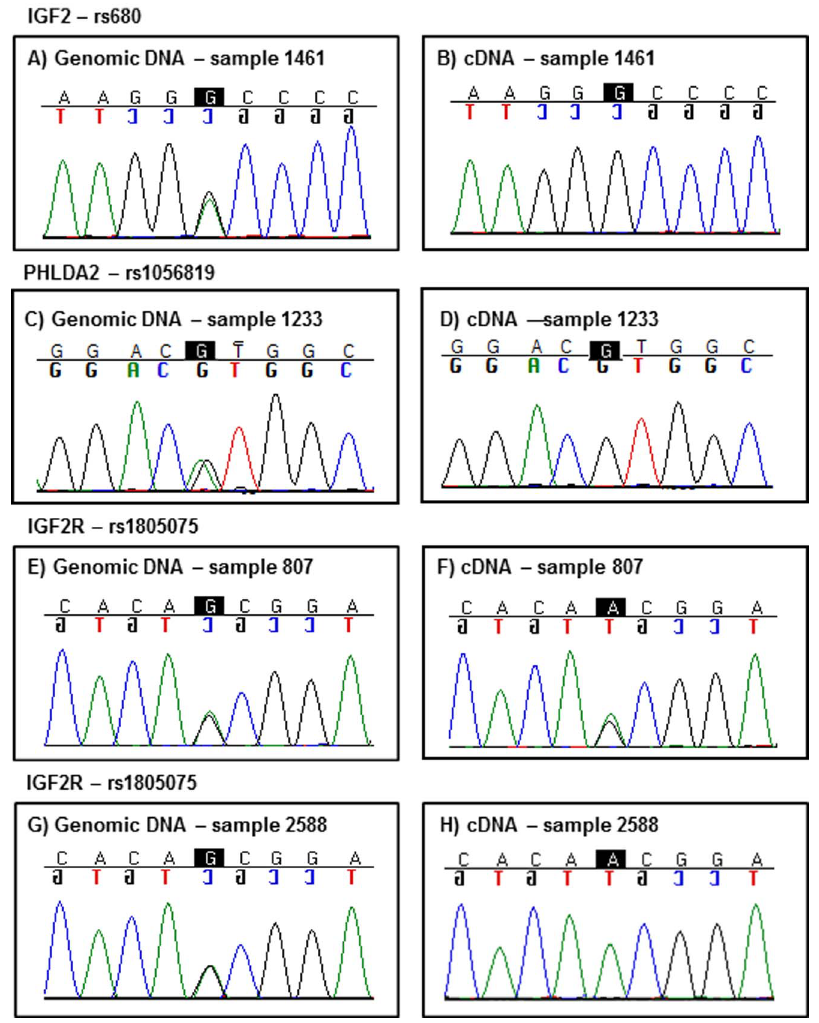
Figure 4. Imprinting analysis of IGF2 , PHLDA2 and IGF2R . Representative sequencing chromatograms are shown from one of the 40 informative CVS samples for the IGF2 A/G polymorphism (rs680) (A, B), one (from 21) for the PHLDA2 A/G polymorphism (rs1056819) (C, D) and two (from 24) for the IGF2R A/G polymorphism (rs1805075) (E, F, G, H). Heterozygous genomic CVS DNA sequence is shown in A), C), E) and G). While monoallelic expression from the corresponding cDNA samples are shown in B), D) and H). Monoallelic expression in cDNA was found in all informative IGF2 and PHLDA2 samples as well as 12% of IGF2R samples. Biallelic expression, as shown in F), was found in the majority (88%) of informative cDNA samples for IGF2R